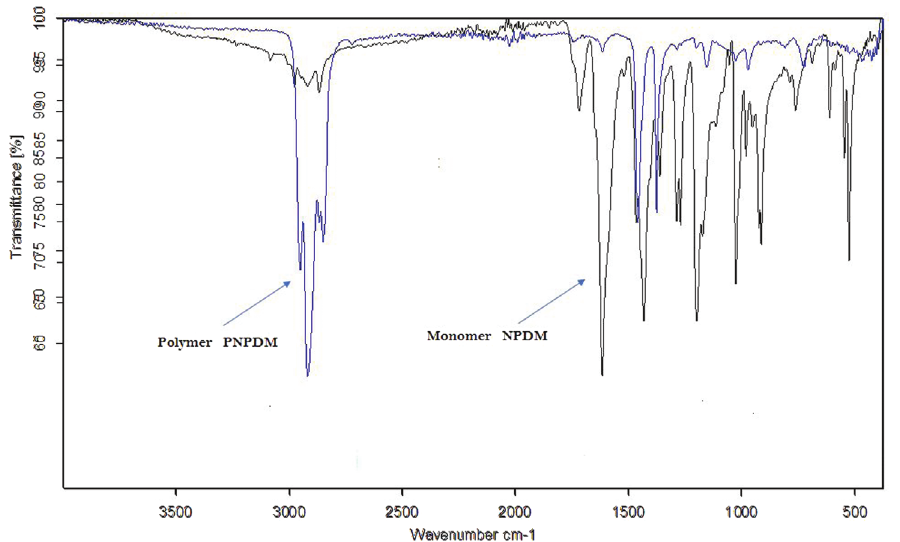
Figure 6: IR spectra of NBMP (black curve) and poly(NBMP) (blue